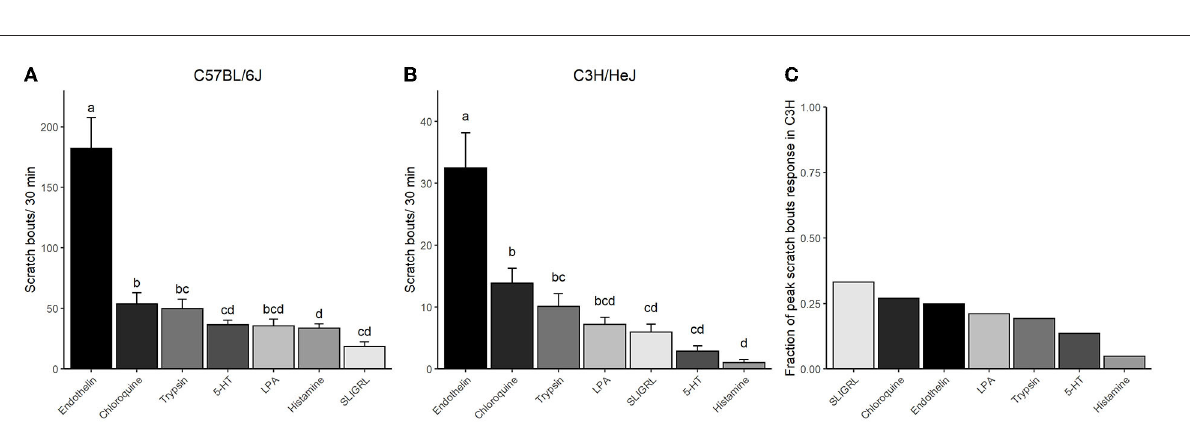
FIGURE3 Comparison of the efficacy of the seven pruritogens in C57 and C3H. Columns represent means ± SEM scratch bouts for 30min following injection of the respective pruritogens at four concentrations into the nape of the neck of (A) C57 and (B) C3H mice. (A,B) The scratch bout response to the respective pruritogens was averaged for the four concentrations and ranked from the largest to the smallest response. p -Values indicate the level of significance and result from a repeated measures ANOVA with Tukey’s HSD PostHoc Test. (C) The bar chart expresses the relative highest scratch response observed in C3H as the fraction of the highest scratch response observed in C57 for each pruritogen (compare Figure 2). The peak scratch bouts taken for the calculation were the highest responses observed for each pruritogen and strain in Figure 2. Groups with homogenous means in panels A and B are marked with the same